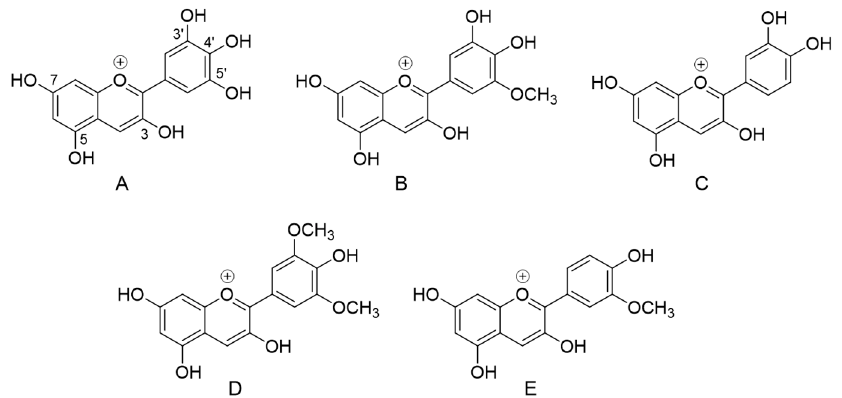
Figure 3. Chemical structures of the anthocyanidin aglycones occurring in Vaccinium myrtillus fruit. ( A ) delphinidin, ( B ) petunidin, ( C ) cyanidin, ( D ) malvidin, ( E ) peonidin.